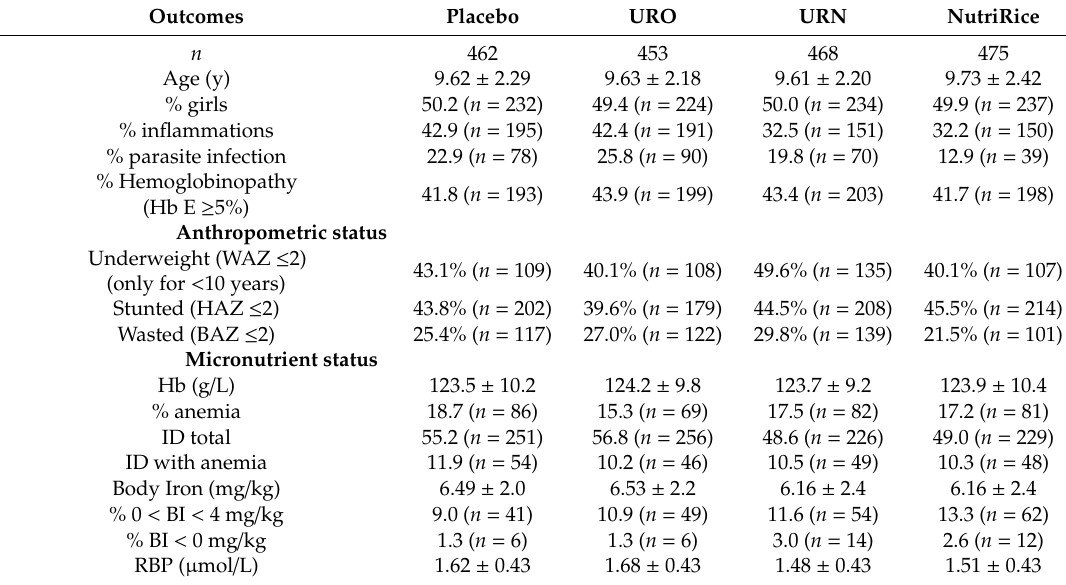
Table 2. Baseline characteristics of children in the study.